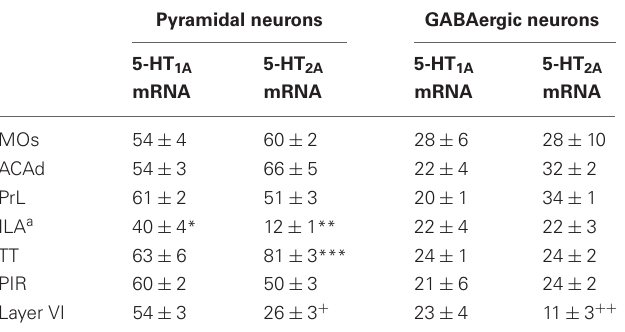
Table 1 | Proportion of pyramidal and local GABAergic neurons that express the mRNAs encoding 5-HT 1A and 5-HT 2A receptors.